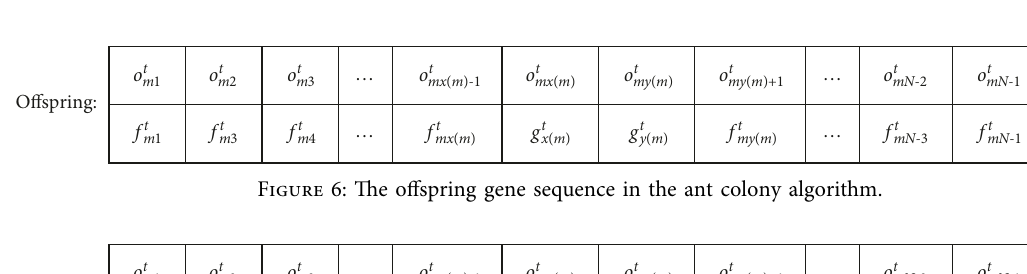
Figure 5: The gene sequence of both parents in the ant colony algorithm.